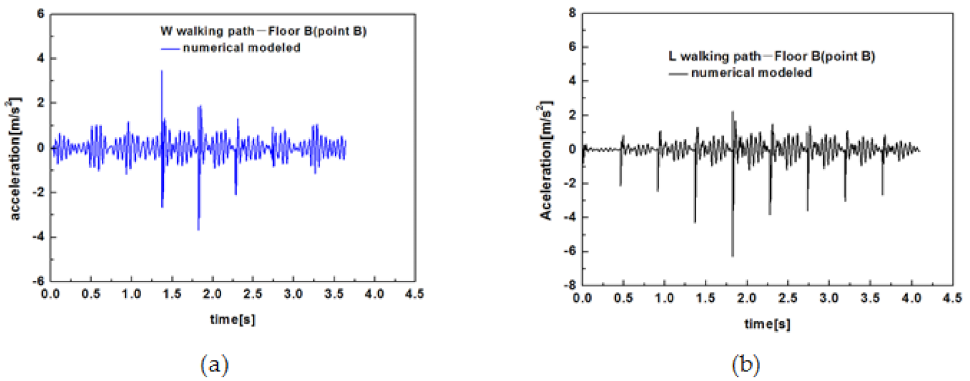
Figure 25. Acceleration responses at points B for Floor B: ( a ) W path and ( b ) L